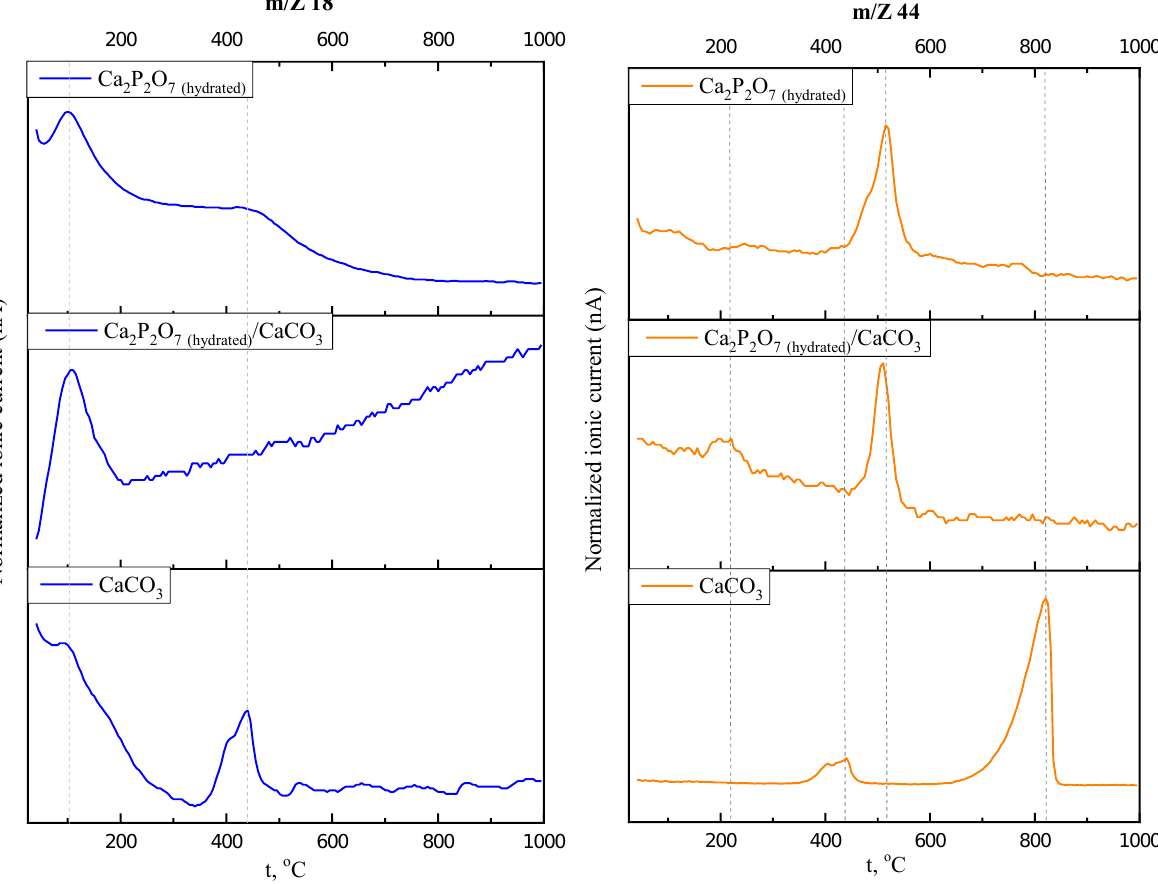
Figure 4. Mass spectrometry data: dependences of ion current on temperature for ionized particles with a mass of 18 (H 2 O) and 44 (CO 2 ) when heating synthesized CPP (Ca 2 P 2 O 7 ), CPP/CC (Ca 2 P 2 O 7 /CaCO 3 ), and CC (CaCO 3 ) powders.